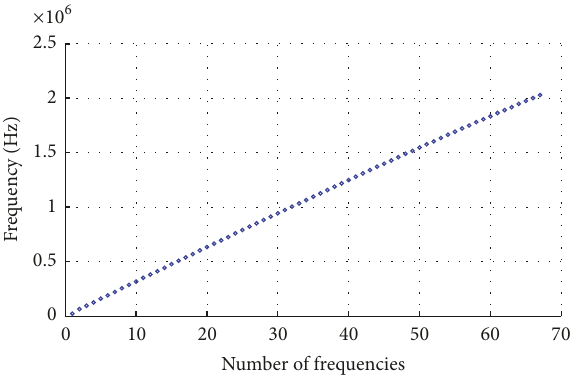
Figure 6: The natural frequencies obtained for the lumped model.